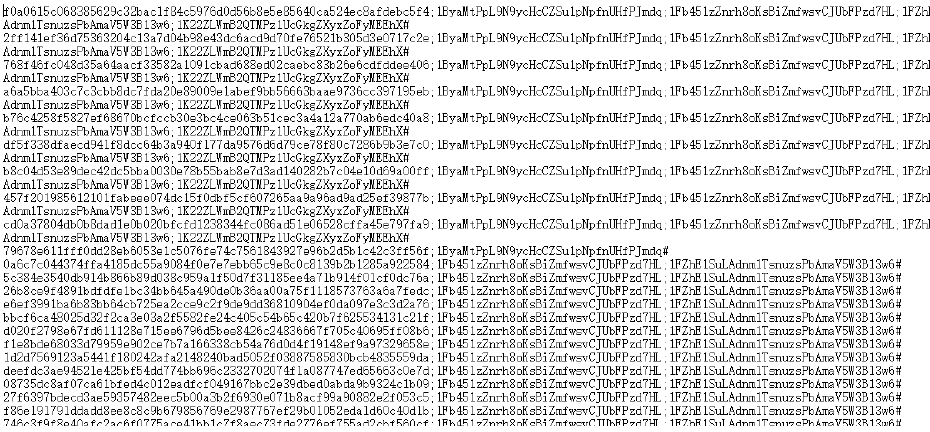
Figure 13. The schematic diagram of “Block Name File” extended by RNS.